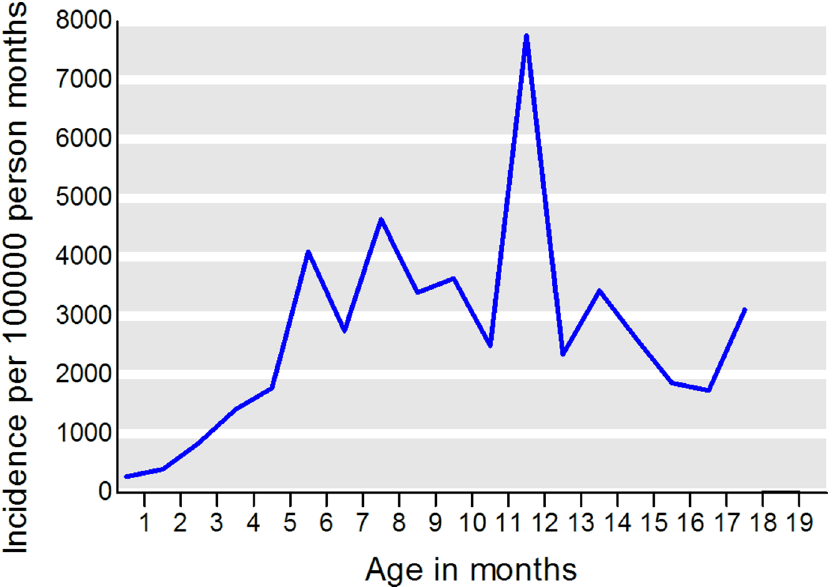
Fig. 2. Risk of OM in the first 18 months of life. Risk of OM in the first 18 months of life (blue line) among 86,044 children in the Danish National Birth Cohort. Based on parents who responded the 6-months, the 18- months or the 7-year interview.